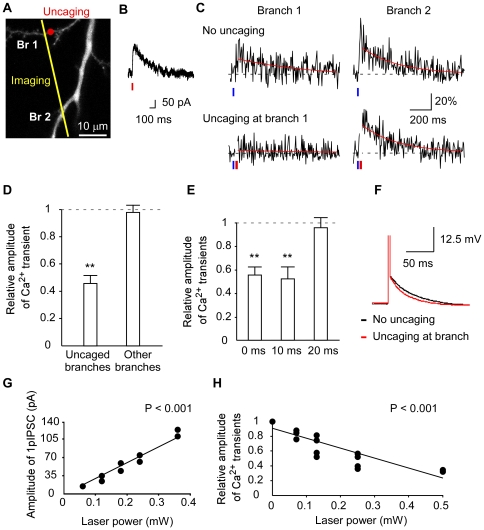
Inhibition of bAP-induced Ca2+ transients by uncaging of RuBi-GABA at oblique dendrites.
A, Fluorescence image (Alexa-594) of a dendrite investigated in (B,C). The red circle in the branch (Br) 1 represents uncaging point. Line scanning was performed along the yellow line for Ca2+ measurements. B, Current trace of 1pIPSC evoked at −20 mV. Uncaging of RuBi-GABA was applied to the red circle in (A). The red vertical line represents the time of GABA uncaging (0.5 mW, 4 ms). C, Normalized changes (ΔF/F) in fluorescence of OGB-1 (0.1 mM) evoked by a single bAP. Inhibition of the Ca2+ transients occurred at branch 1, but not at branch 2. Uncaging was applied 10 ms after bAP. Blue and red vertical lines denote the times for bAP induction and GABA uncaging, respectively. We masked the traces during 473 nm laser irradiation for GABA uncaging. D, Inhibition of bAP-induced Ca2+ transients in the branches which were applied with GABA uncaging or not. The amplitudes of the Ca2+ transients with GABA uncaging were normalized by those without. Bars represent the mean ± SEM. The relative values are different from 1.0 with ** P<0.01 (t-test, n = 8). E, Time dependence of Ca2+ inhibition by GABA uncaging. Uncaging was applied 0 ms, 10 ms, or 20 ms after bAP induction. Ca2+ imaging was performed at the site of uncaging. The relative values differ from 1.0 with ** P<0.01 (t-test, n = 6–10). F, Example of the effect of GABA uncaging on spike after-depolarization. G, Laser-power dependence of the amplitudes of 1pIPSCs induced by GABA uncaging at the soma. The correlation is significant (P<0.001). H, Laser-power dependence of inhibition of the Ca2+ transients by GABA uncaging at oblique dendrites. The correlation is significant (P<0.001).